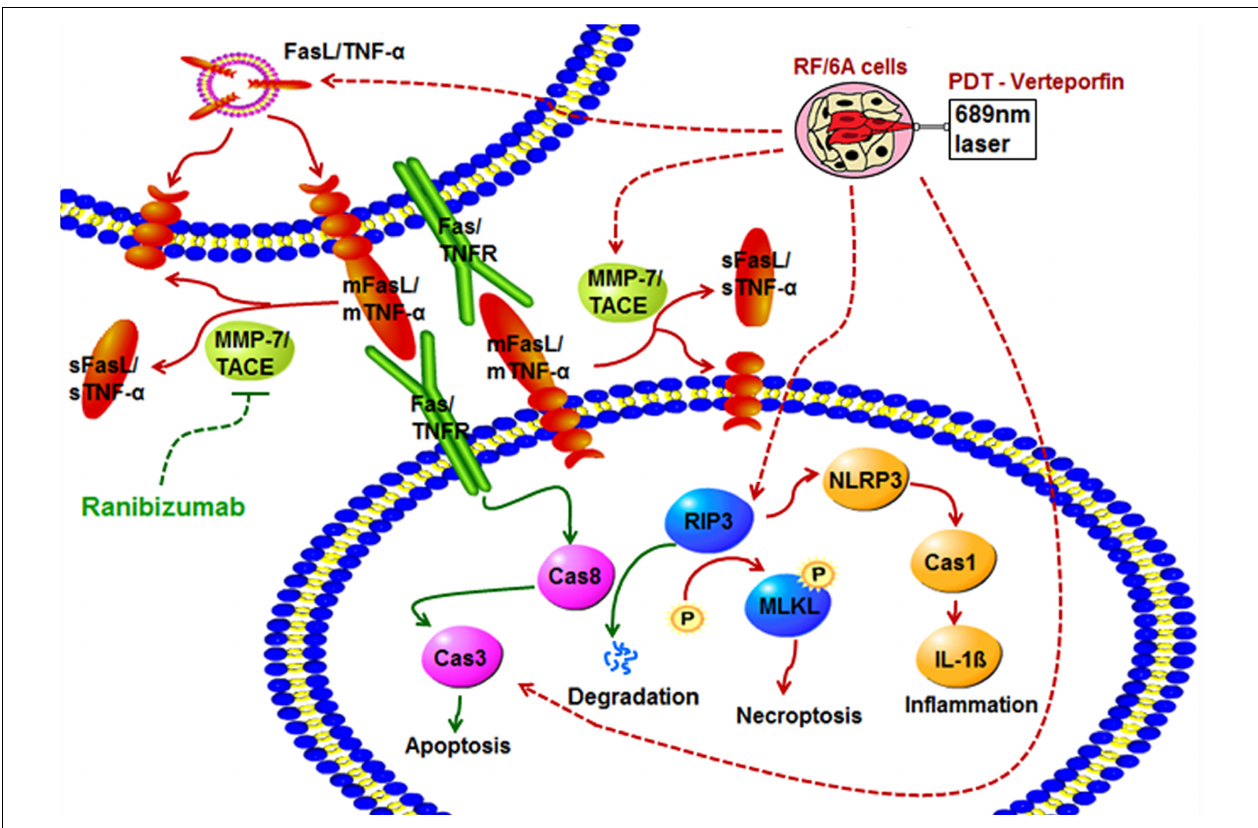
FIGURE 6 | The effects of pre-treatment with rani on PDT injury in RF/6A cells and possible signaling pathways involved. PDT activates apoptosis, necroptosis and NLRP3 inflammasome in RF/6A cells. Pre-treatment with ranibizumab promotes PDT-caused apoptosis via triggering caspase 8-mediated extrinsic apoptosis, and caspase 8 might also play a pivotal role in the ranibizumab’s function of suppressing PDT-induced necroptosis and NLRP3 inflammasome